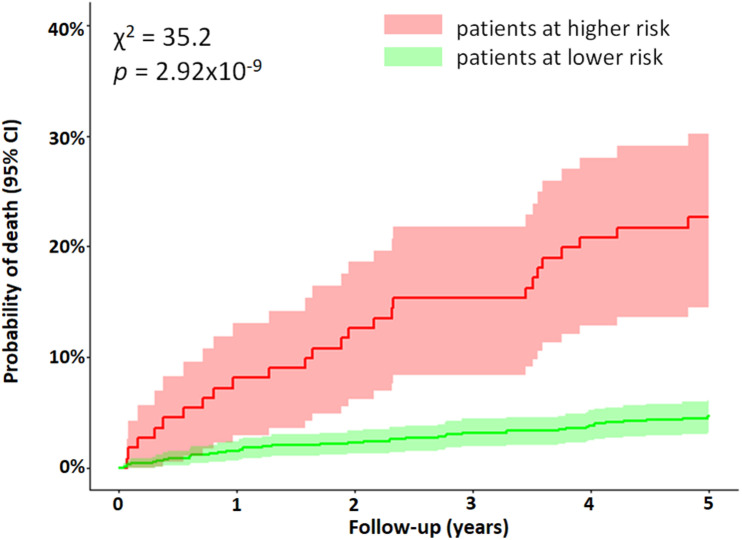
Mortality of MI patients stratified by the QTV risk score. Kaplan–Meier curves were obtained from the dichotomized multivariable Cox regression model. The red curve represents patients above the cut off value (0.626), while the green curve represents all other patients. Difference between the two curves was tested using the log-rank test (χ2 = 35.2, p = 2.92×10– 9). The figure demonstrates the predictive value of an increase in QTV risk score for identifying patients with a higher risk of mortality post MI.